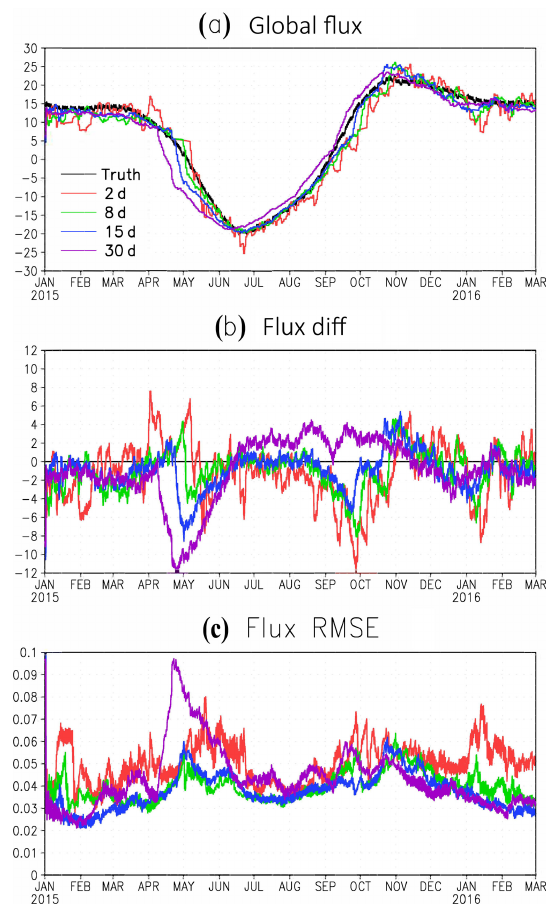
Figure 4. Same as Fig. 2, except for the second set of experiments with different OW but the same AW of